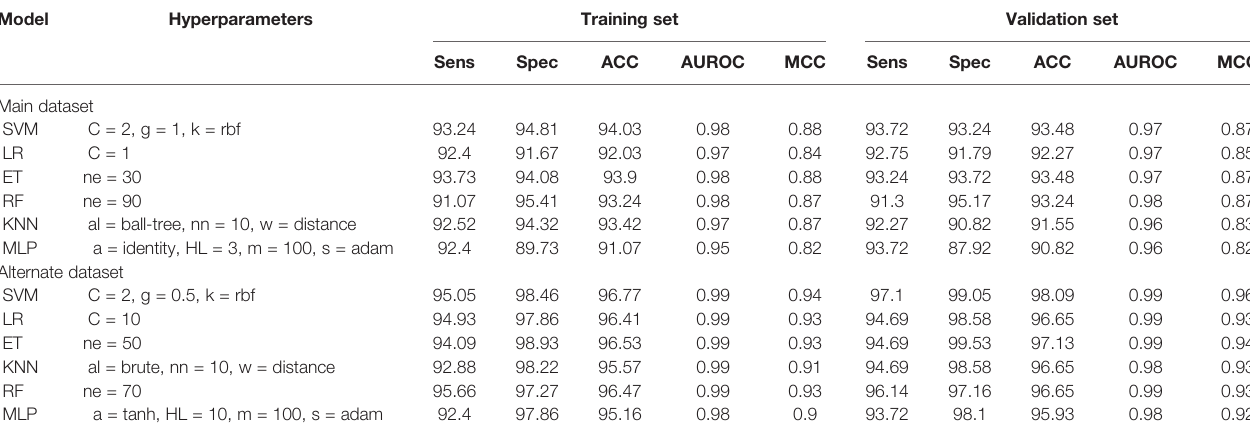
TABLE 1 | The performance of the machine learning models on SVC-L1 selected features for both datasets. Model Hyperparameters